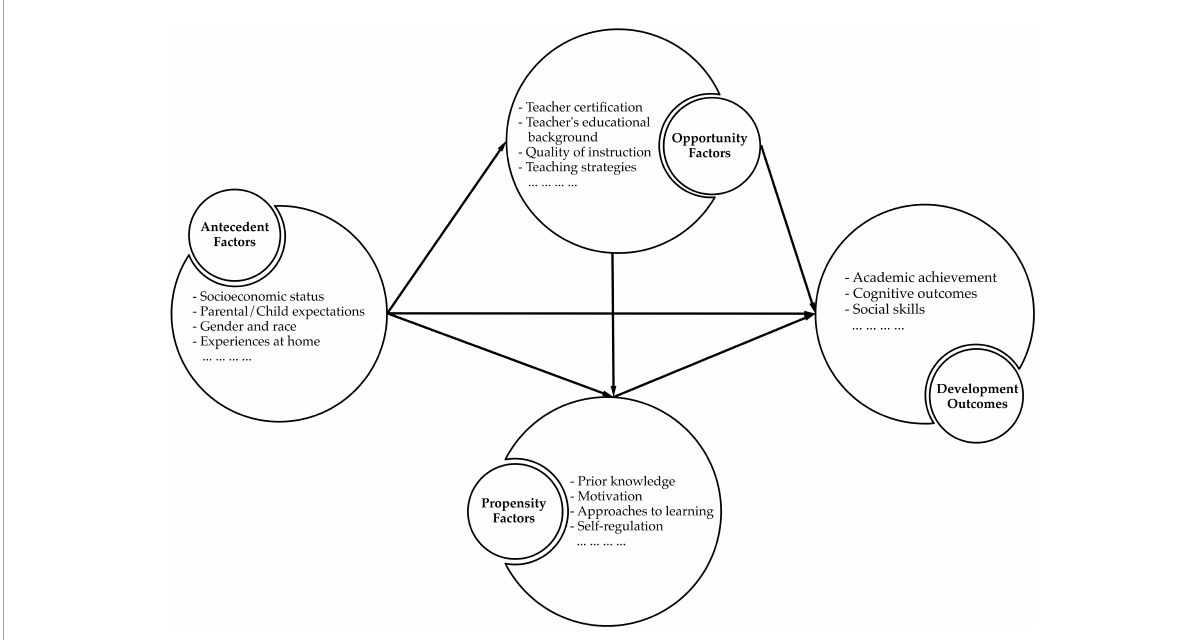
FIGURE5 The original and the latest combined version of the of Opportunity-Propensity framework (adapted from Byrnes and Miller, 2007; Byrnes and Wasik, 2009; Byrnes and Miller-Cotto, 2016; Byrnes,